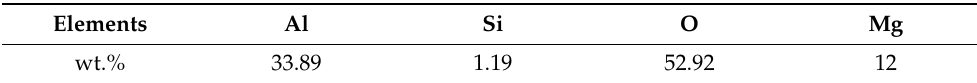
Table 6. EDS results for the GHS after